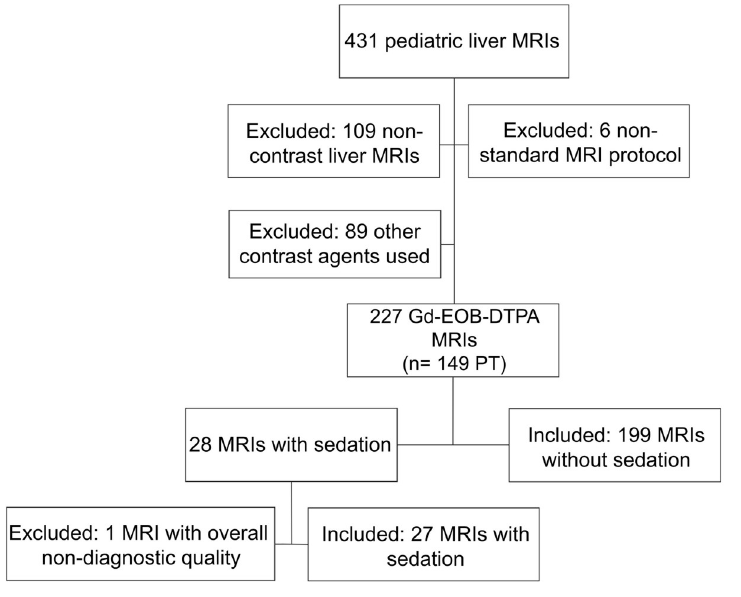
Fig 1. Flowchart of the included